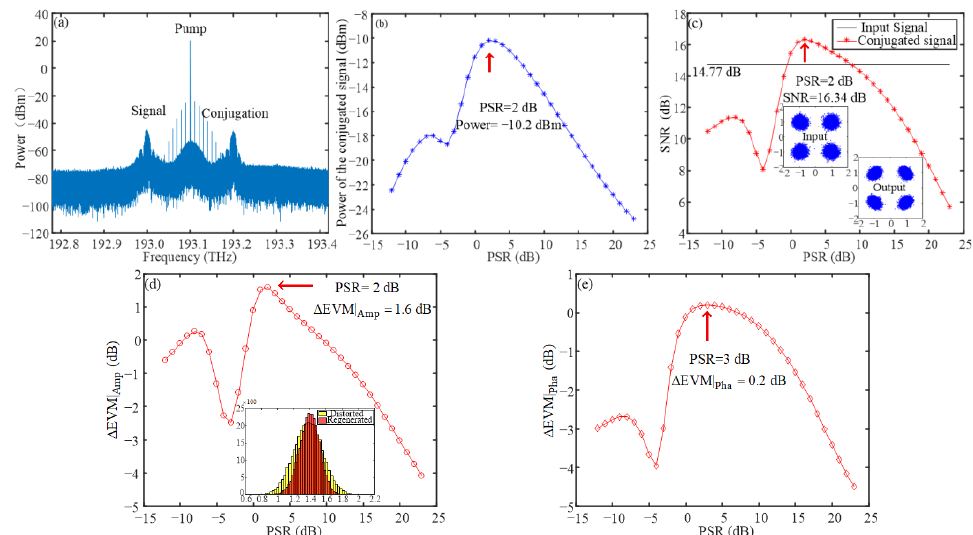
Figure 4. ( a ) Optical spectrum in the YB case; ( b ) power curve of the conjugated signal with PSR; ( c ) relation between SNR and PSR; ( d ) the amplitude EVM gain ΔEVM| Amp; and ( e ) the phase EVM gain ΔEVM| Pha on the input PSR.